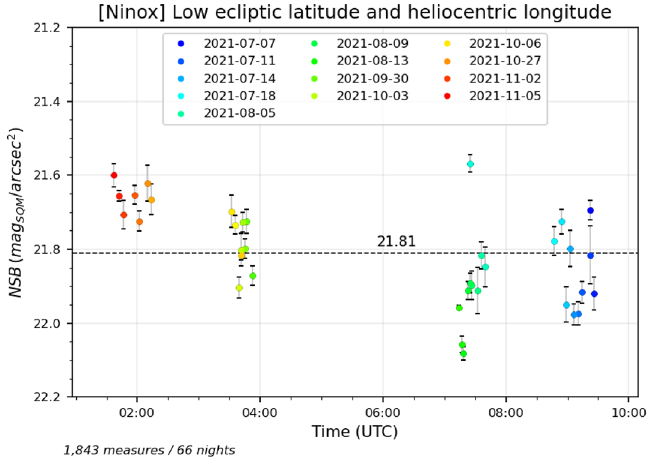
Figure 6. Measures obtained during moonless nights with good clear sky conditions where (1) the galactic latitude absolute value is greater than 70 ◦ (2) the ecliptic latitude of the zenith is comprised between − 30 ◦ and 30 ◦ (3) the zenith helioecliptic longitude is lower than 160 ◦ . This corresponds to situations where the zenith is far from the Galactic plane but close to the ecliptic plane and at lower angular distances from the Sun than in Fig.